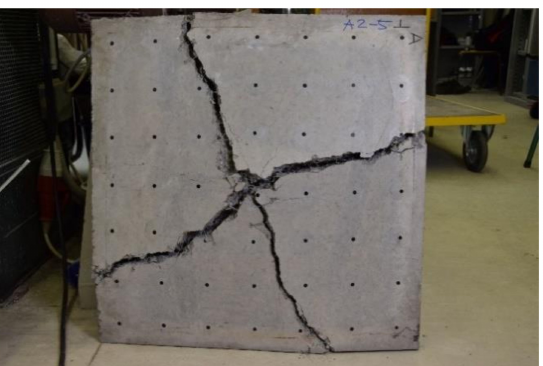
Figure 16. Specimen A2_5 after load test with cracks development typical after static loading.